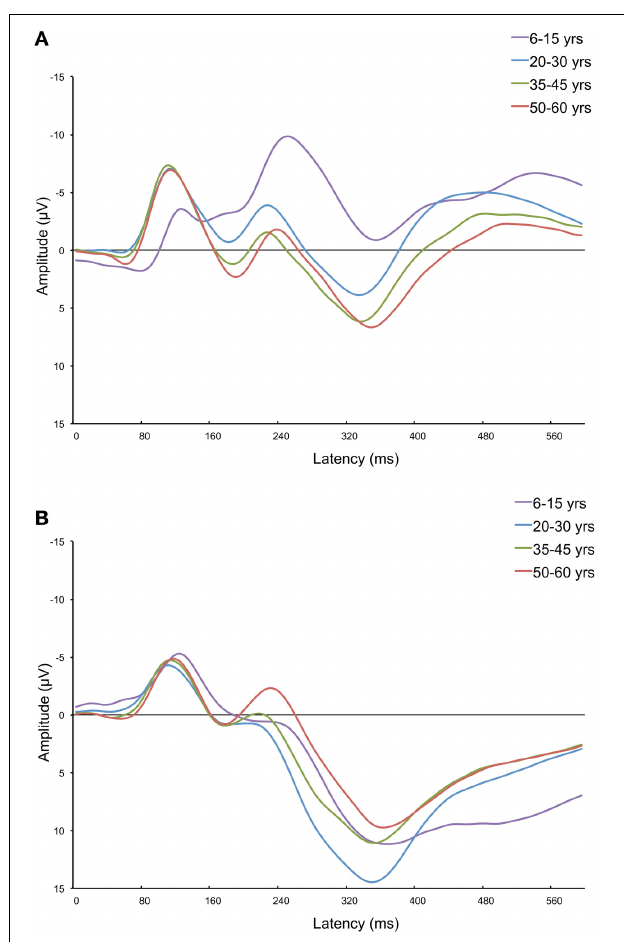
FIGURE 5 | Frontal (Fz; A) and parietal (Pz; B) grand average ERPs of four age groups: 6–15, 20–30, 35–45, and 50–60 years old. This figure further visualizes the differences in how the frontal and parietal P300 are affected by increasing age. The frontal P300 amplitude increases with age, and the parietal P300 amplitude develops in a curvilinear way with age (an increase for children and a decrease for adults). Also note parallel changes on the N200 component (not investigated in this